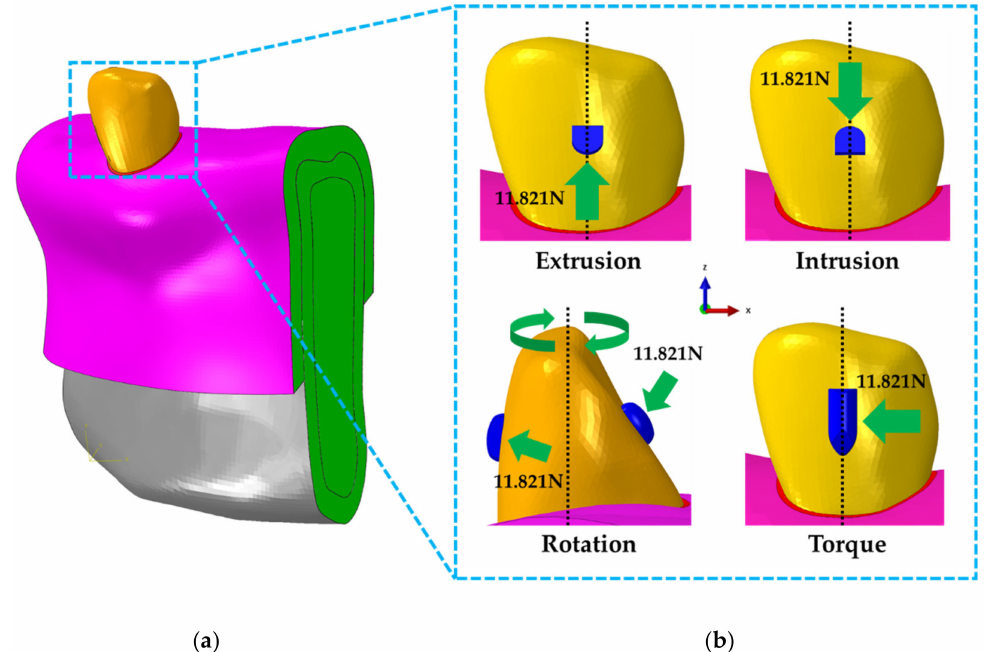
Figure 7. Boundary and loading conditions for orthodontic treatment models considering 4 types of attachments. ( a ) Both sides of the bone model (Green) were fixed in all directions; ( b ) For extrusion and intrusion, 11.821N was applied in the direction of the z-axis on the contact surfaces of the attachments at the gingival and incisal sides. For torque attachments, − 11.821N was applied in the direction of x-axis. In addition, as for the rotation attachments, pure moment was applied by applying 11.821N perpendicularly to the plane cut 65 degrees to the attachment at the buccal and lingual